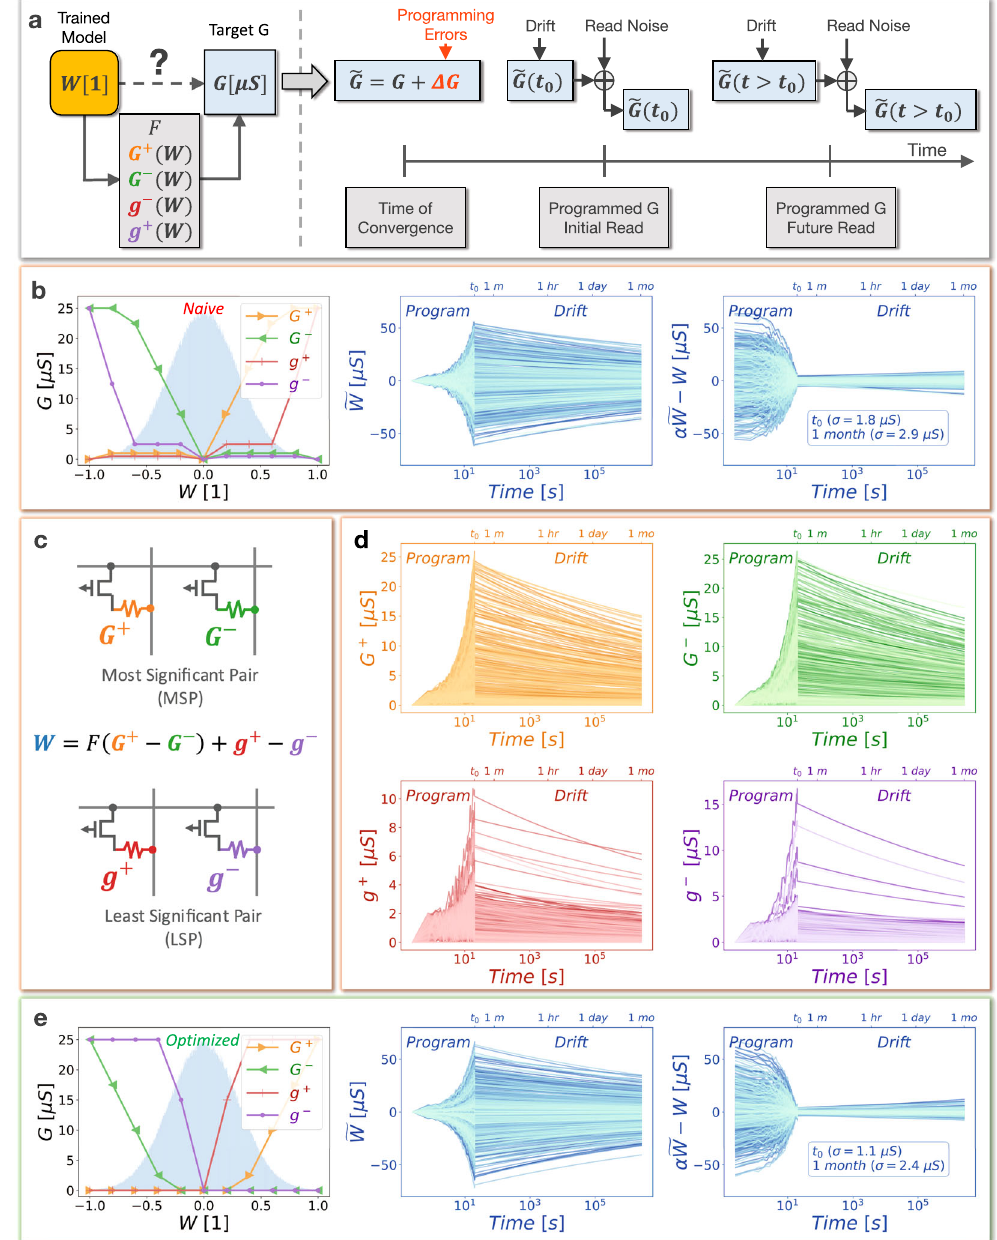
Fig. 2 Impact of different programming strategies on weight fi delity. a Unitless weights of software-trained DNN models are translated to analogue memory-based synaptic weights comprised of multiple conductances, which are subject to imperfections including programming errors, conductance drift, and read noise. b A sub-optimal weight programming strategy for a distribution of weights (blue) leads to outsized hardware weight errors at t 0 that become progressively worse with time, even after drift compensation factor α is applied. c Each synaptic weight may be comprised of multiple conductances of varying signi fi cance as indicated by the factor F , which separates the Most Signi fi cant Pair (MSP) and Least Signi fi cant Pair (LSP). d Individual conductance-programming errors are compounded by subsequent drift over time. e An optimised weight programming strategy for the same weight distribution (blue) results in minimal weight errors as indicated visually and by the lower standard deviation in weight